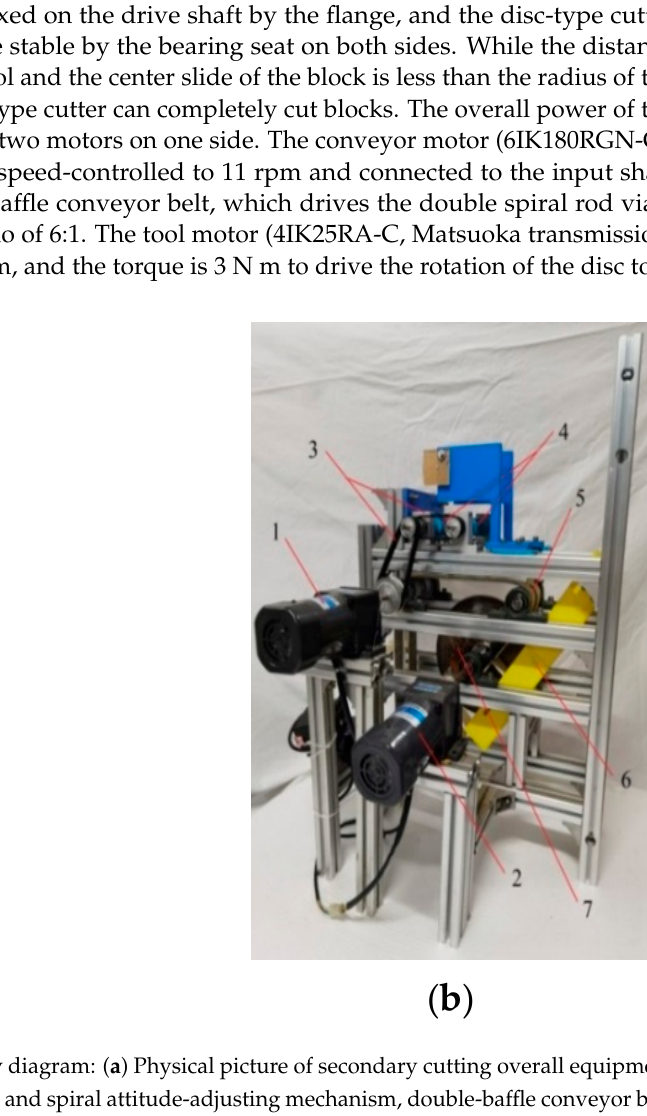
disc-type cutter can cut the block along the middle of its longest size to complete secondary cutting. The control flow is shown in Figure